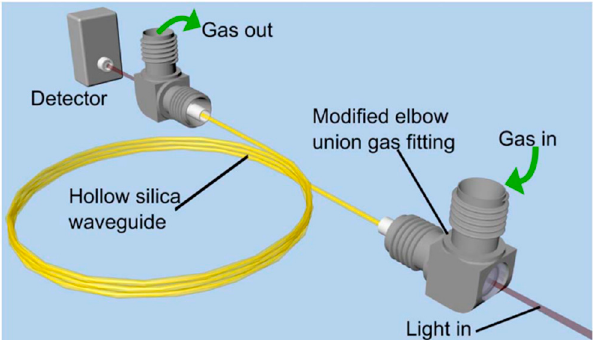
Figure 5. Schematic diagram of the gas cell based on a hollow capillary fiber/waveguide with elbow fittings used to couple gas and light in and out of the fiber. Reprinted with permission from [24], © The Optical Society.